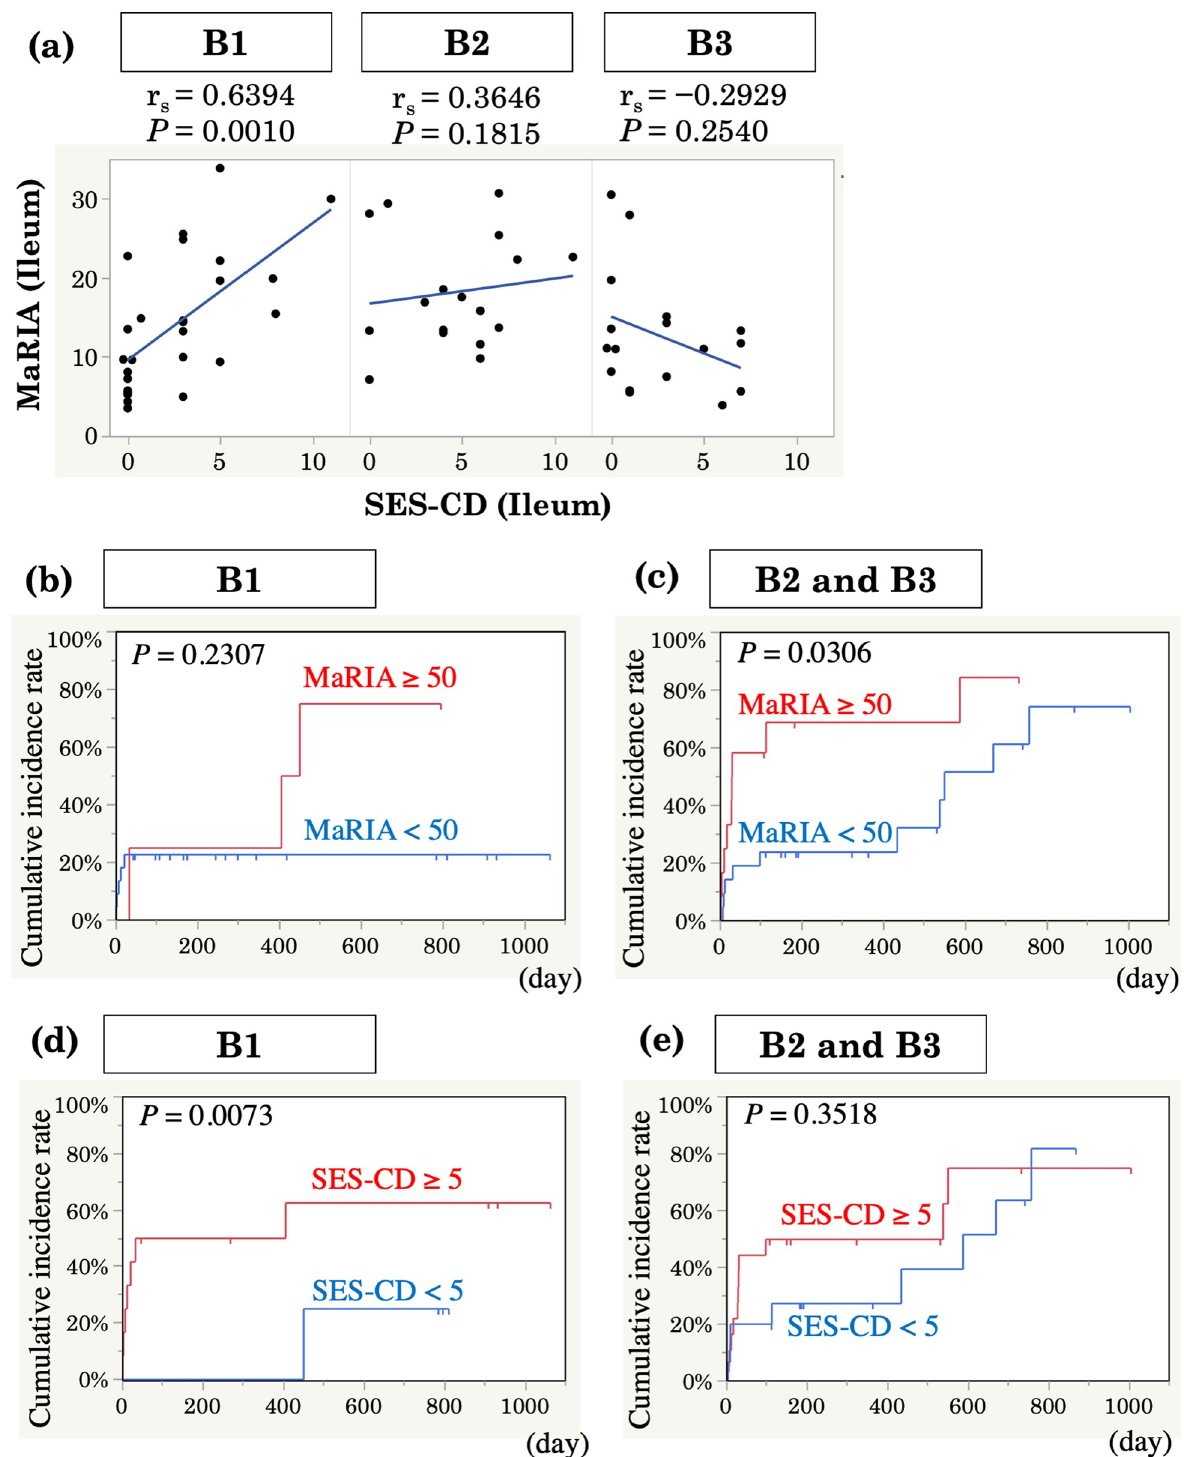
Fig 4. Usefulness of MRE in predicting early need for treatment escalation in patients with stricturing or penetrating disease. (a) Correlation between the SES-CD and MaRIA score in the distal ileum according to the Montreal classification. (b) Kaplan–Meier estimates of the cumulative incidence of treatment escalation according to MRE findings in patients with B1 (without strictures or penetrating disease, n = 26) or (c) B2/3 (with strictures or penetrating disease, n = 34) disease. (d) Kaplan–Meier estimates of the cumulative incidence of treatment escalation according to endoscopic findings in patients with B1 or (e) B2/3